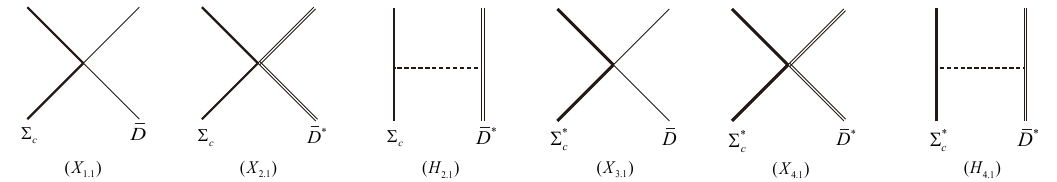
(cid:22) D ( X (cid:22) D (cid:3) ( X (cid:3) 3 : 1 ) and (cid:6) 4 : 1 ; H 4 ; 1 ) systems. We use the thin c c